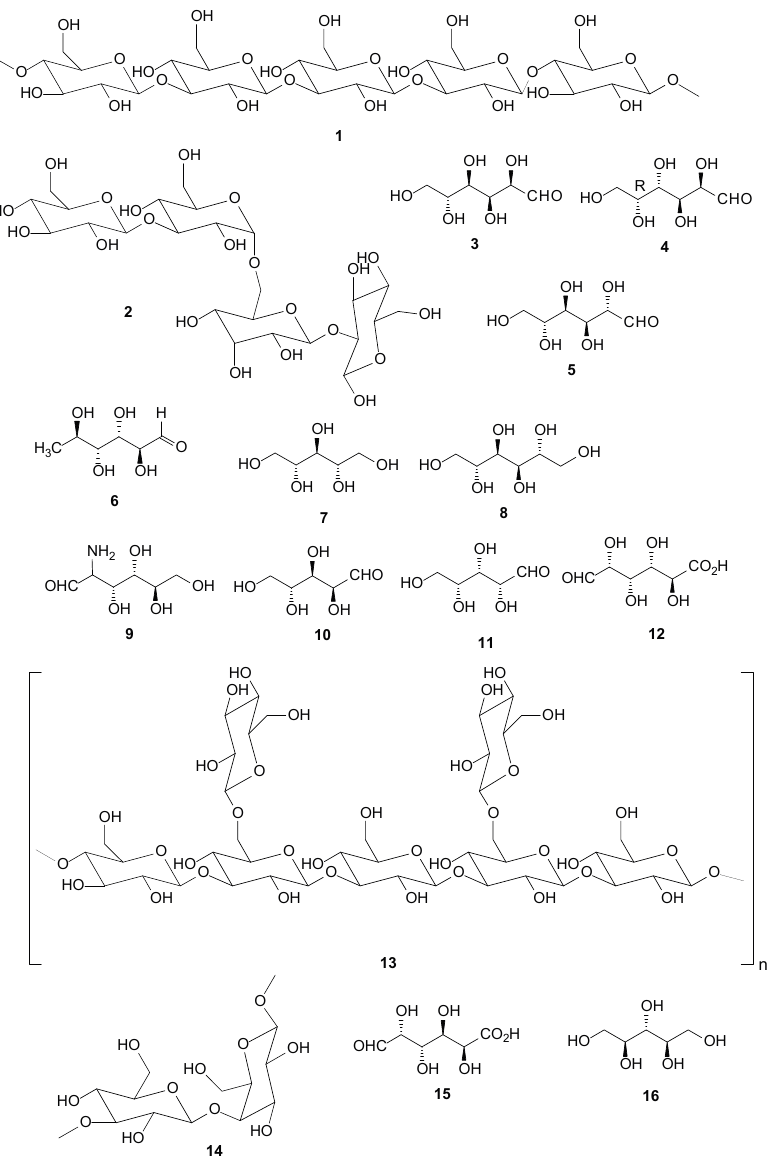
Figure 1. Chemical structures of polysaccharides of Ramalina species of lichenized